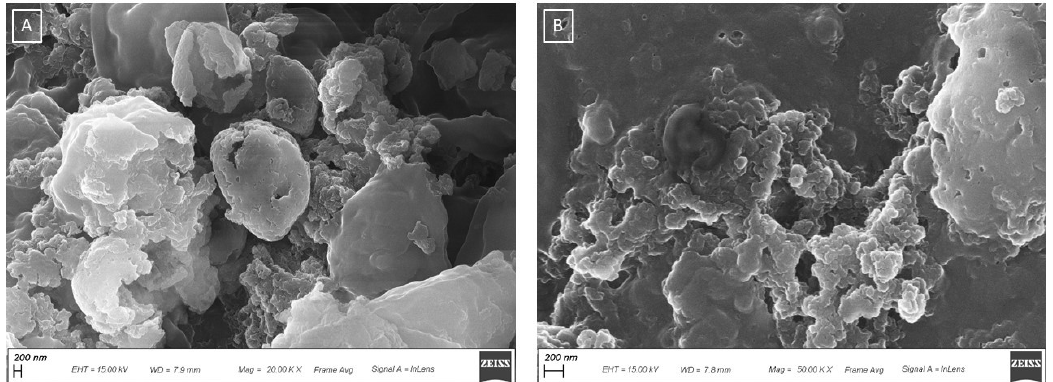
Figure 5. SEM images of lyophilized SWL showing yeast cells breakdown and cellular aggregation. SEM of ( A ) SWL (20.00K X) and ( B ) SWL (50.00K X).